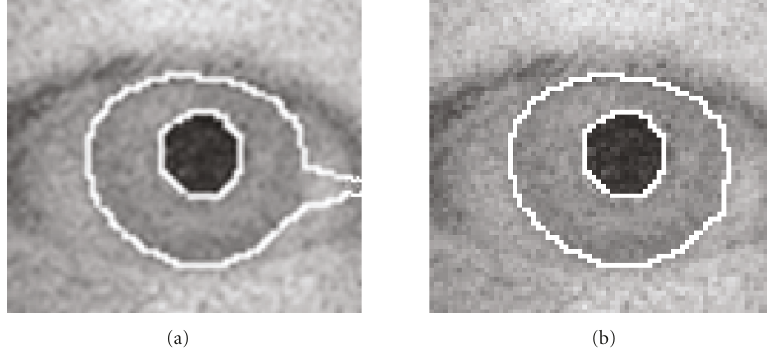
Figure 2: Iris segmentation with noisy samples (a) without and (b) with area preserving capability.